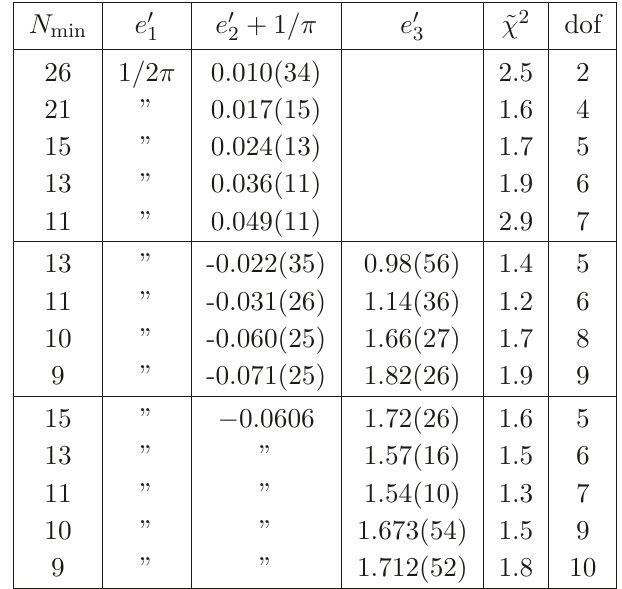
Table 5 . In this table we report systematics for the determination of the large- N behavior of ξ 2 χ using the N 2 ansatz in eq. (4.8). Conventions are the same as in table 3. − a/ ( N 2)+ g N , but this expression is exactly equivalent to eq. (4.6) with f N = a +( N −